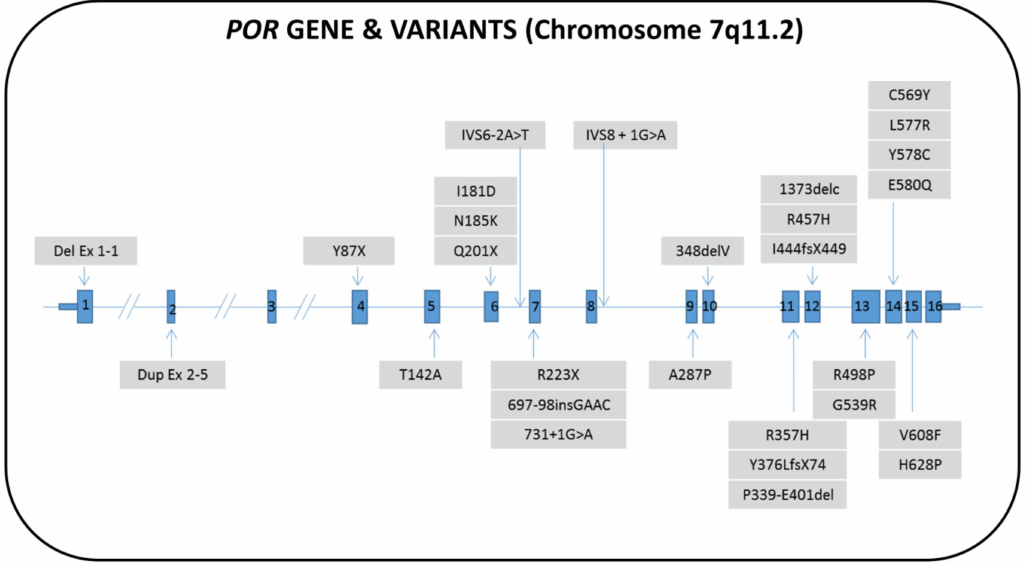
Figure 7. Structure of the human POR gene with the pathogenic variants that have been described in 46,XX patients. The nomenclature of the pathogenic variants is in accordance with the references cited in Supplementary Table S4. The genotype / phenotype correlation is not shown, due to the high variability of the reported